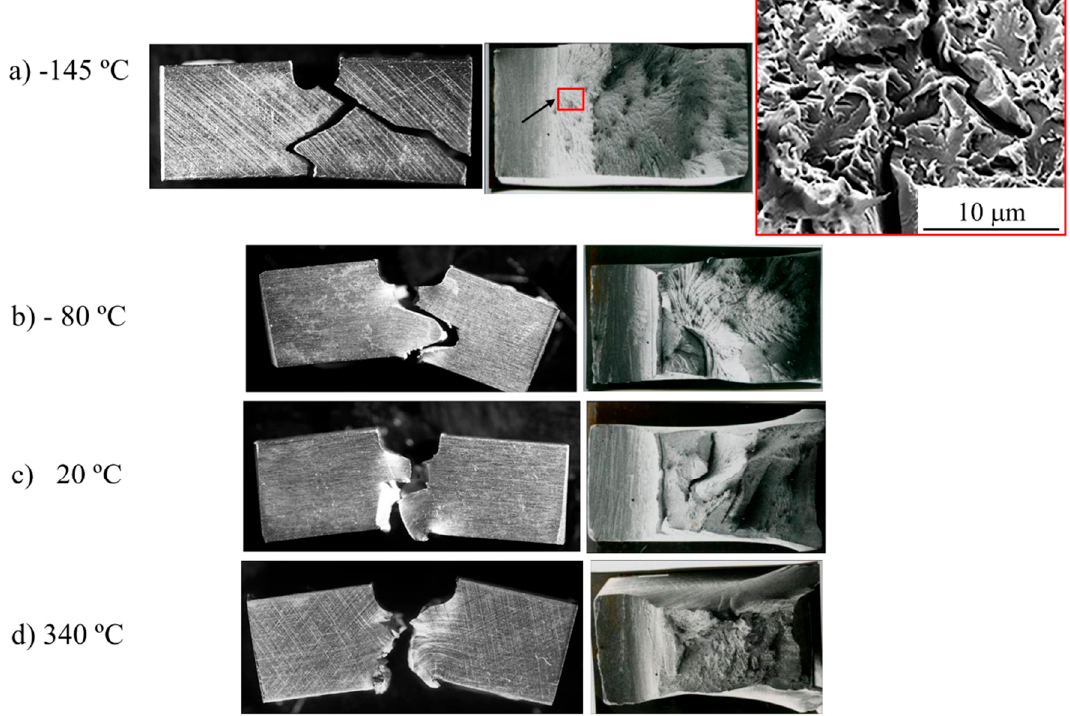
Figure 10. Appearance of Charpy impact test specimens of MA956 alloy after fracture at ( a ) − 145 °C; showing the fracture profile ( left ), the location of the fracture initiation ( middle ), and the microscopic features of the fracture surface ( right ); ( b ) − 80 °C; showing the fracture profile ( left ) and the location of the fracture initiation point after of ductile stable crack growth and the delaminations ( right ); ( c ) +20 °C; showing the fracture profile ( left ) and the fracture surface in which delaminations are observed; ( d ) 340 °C; showing the fracture profile ( left ) and the ductile aspect of the fracture surface ( right ).